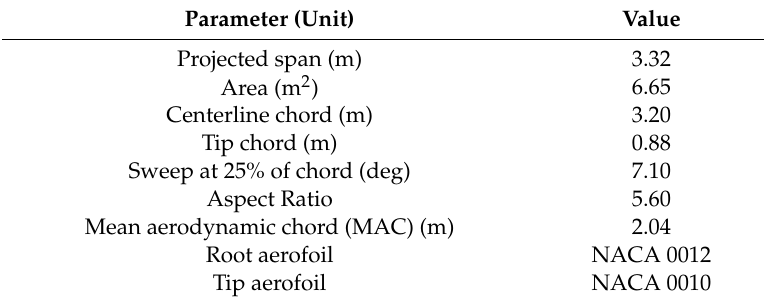
Table 6. Vertical tail plane geometrical reference data (geometry information from [25,26]).